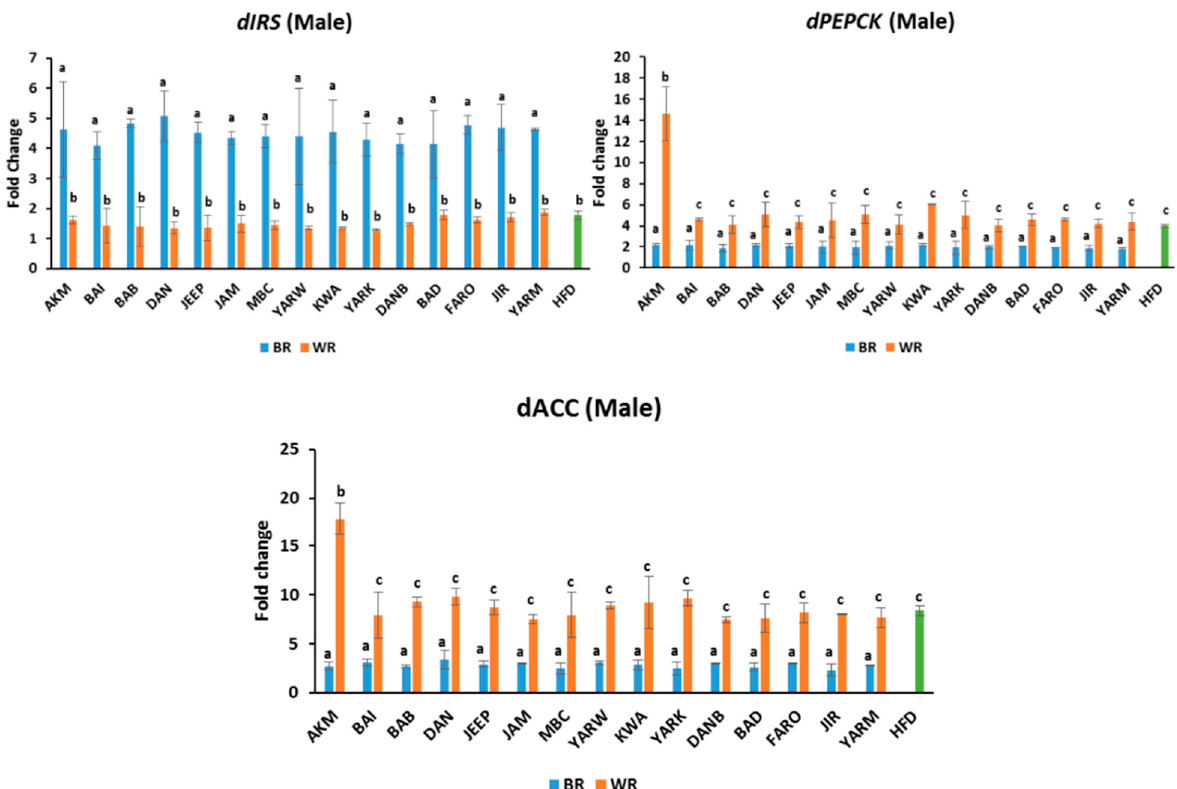
Figure 5. dIRS , dPEPCK , and dACC expressions in male flies exposed to different rice cultivars for 7 days. Fold change was calculated using Livak method (2 − ∆∆ CT ). Bars represent mean ± SD. Bars denoted by the same letters are not significantly different ( p > 0.05). (n = 20). Green bar represent the group fed high ‐ fat diet. HFD = high ‐ fat diet, Akai maza hajj = AKM, Baingila = BAI , Baburashi = BAB, Jamila = JAM, Maibakincarki = MBC, Yarwasagi = YARW, Kwandala = KWA, Yarkatabore = YARK, Danboto = DANB, Bakindanboto = BAD, Faro 44 = FARO, Jirkita = JIR, Yarkukuma = YARM, Dankaushi = DAN, Jeep = JEEP.